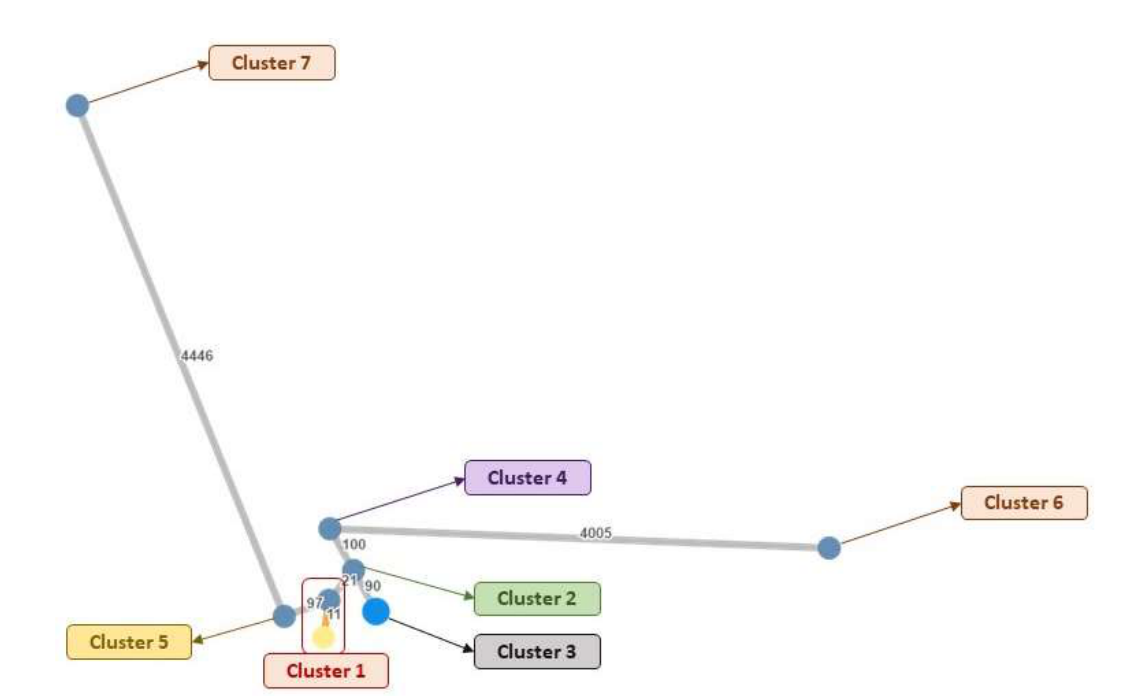
Figure 2. A minimum spanning tree based on the number of allelic differences between the isolates. The number of allelic differences are indicated on the lines connecting the isolates.